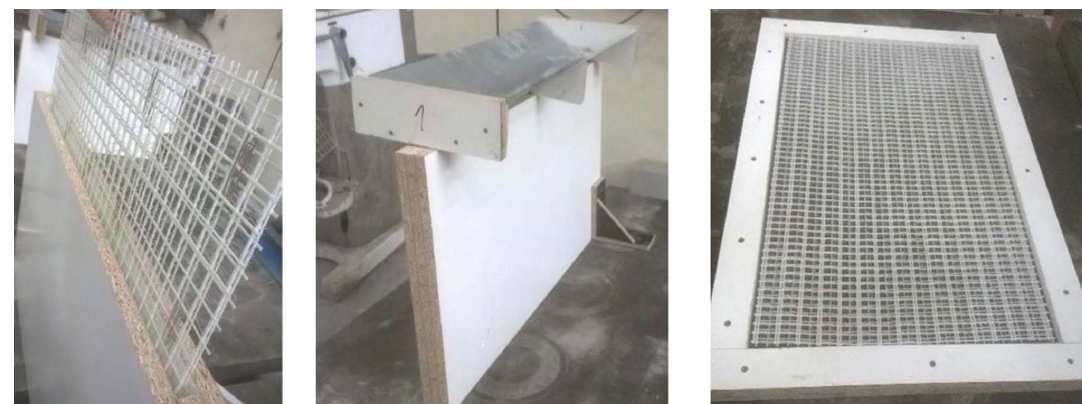
Figure 4. Formwork for TRLC slabs with 3D glass